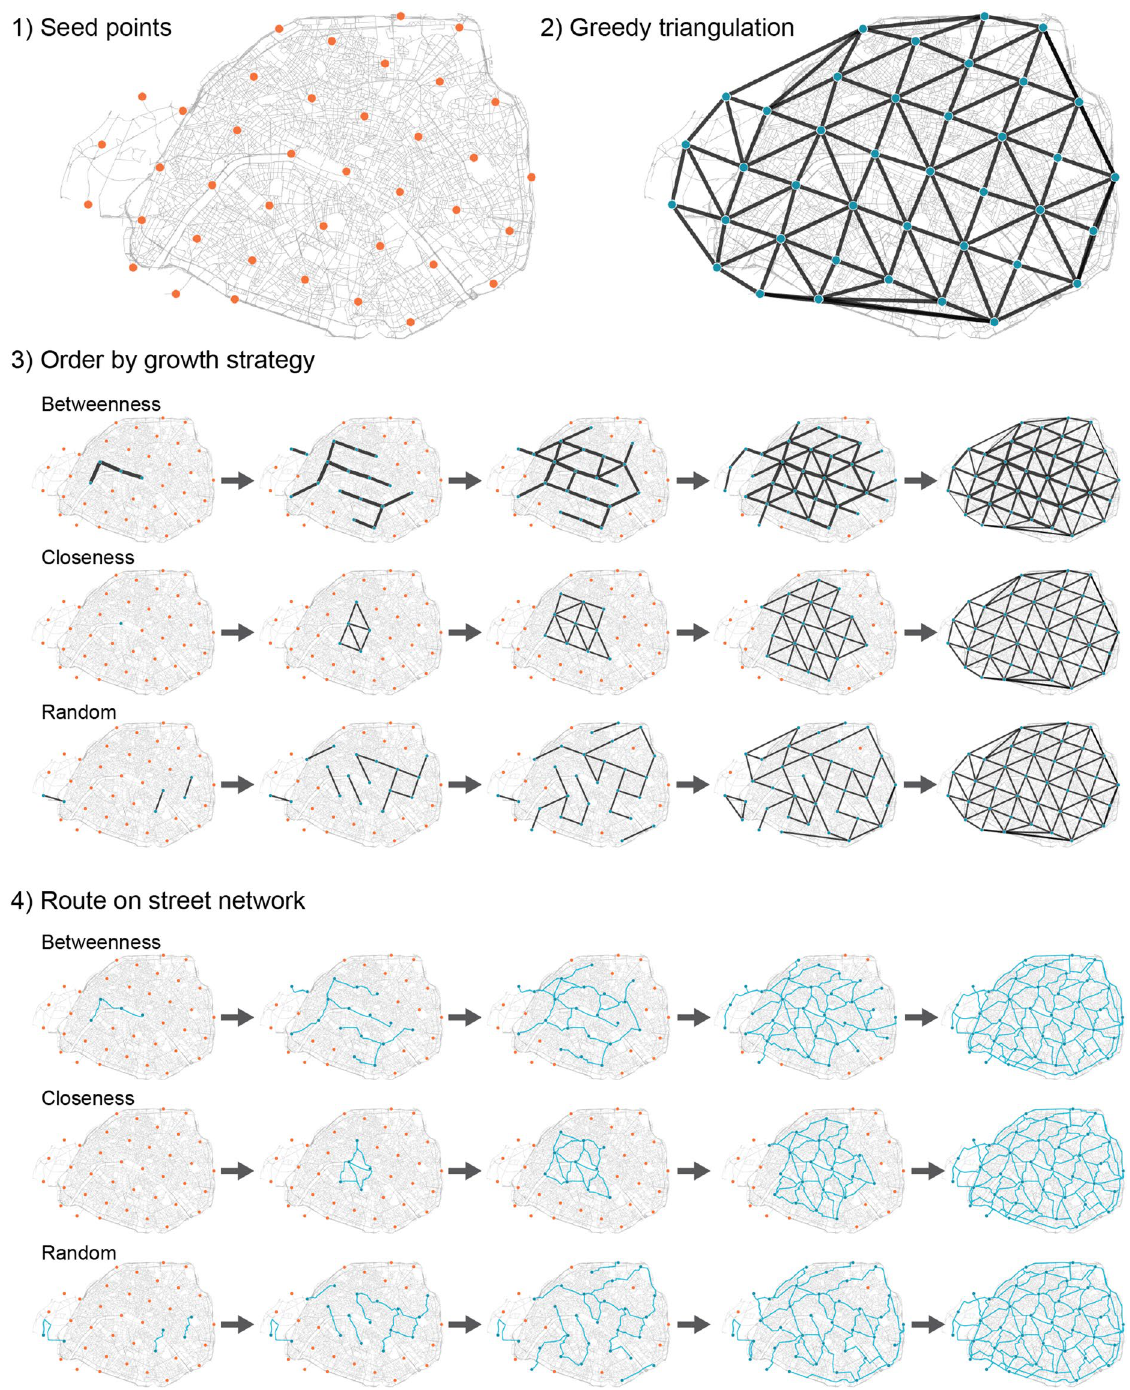
Figure 3. Growing bicycle networks. Explorable interactively at: https:// growb ike. net. Illustrated here for Paris. Step (1) Seed points: A set of seed points (orange dots) is snapped to the intersections of the street network. Shown are grid points, alternatively we investigated rail stations. Step (2) Greedy triangulation: The seeds are ordered by route distance and connected stepwise without link crossings. Reached seeds are colored blue. Step (3) Order by growth strategy: One of three growth strategies (betweenness, closeness, random) is used to order the triangulation links from the strategy’s 0-quantile (empty graph) to its 1-quantile (full triangulation), resulting in 40 growth stages. Shown are the five quantiles q = 0.025, 0.125, 0.25, 0.5, 1 . Step 4) Route on street network: The links in the growth stages are routed on the street network. These synthetic bicycle networks are then analyzed for all 62 cities. Maps created with: https:// github. com/ mszell/ biken wgrow th